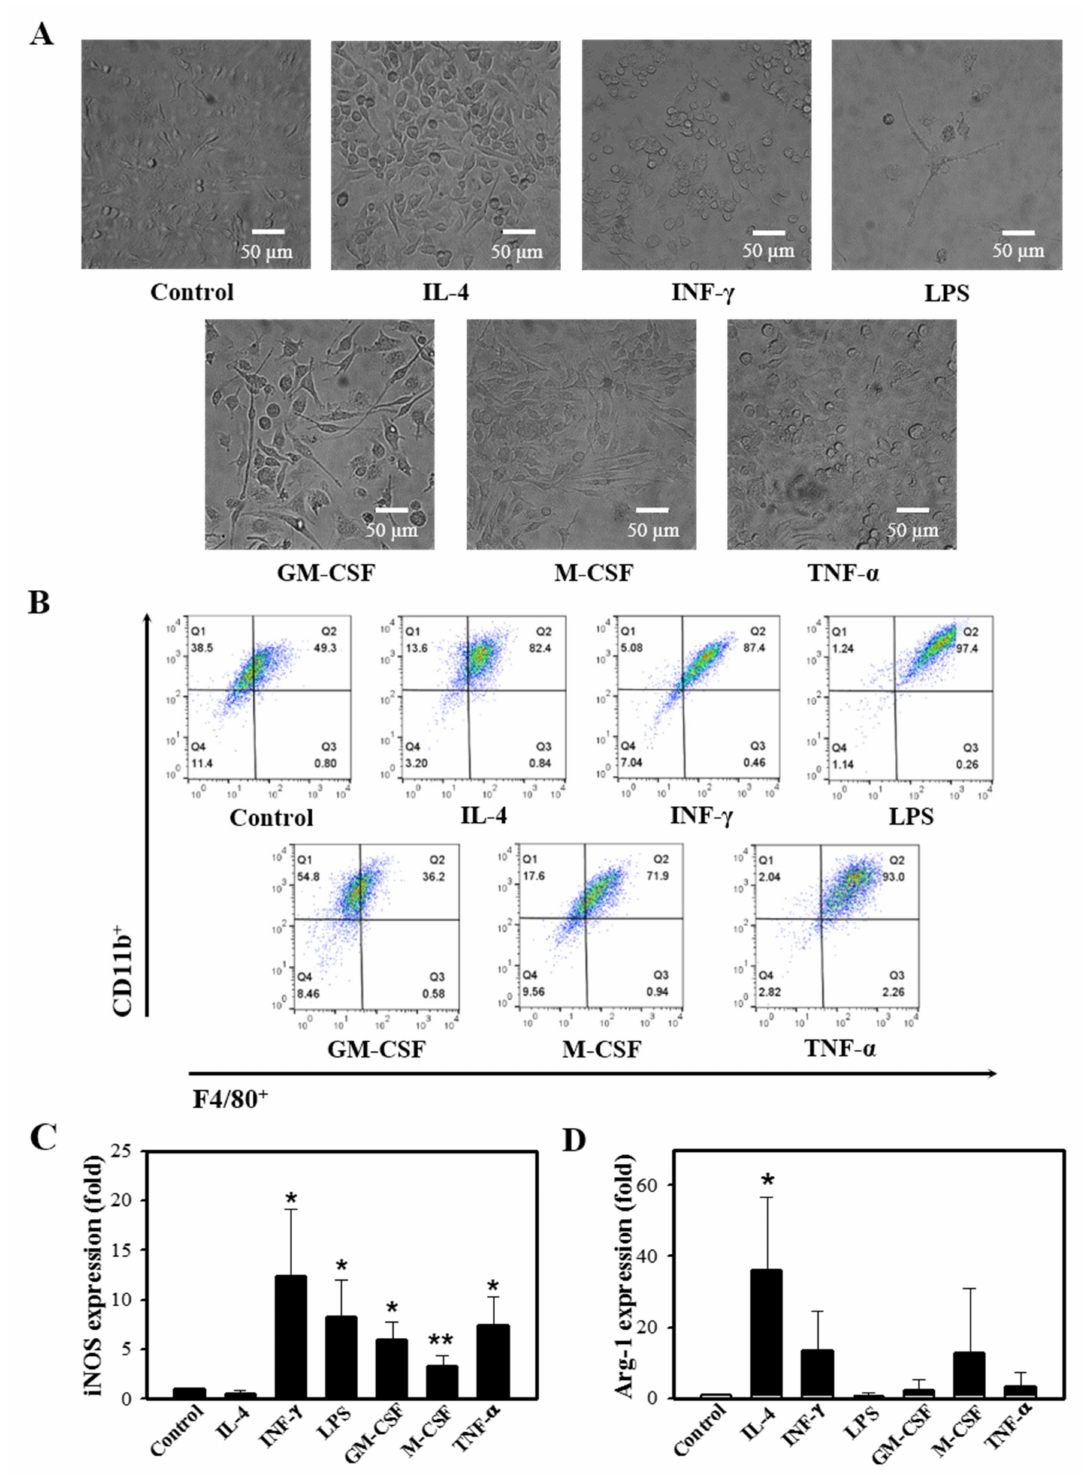
Figure 3. Different ligands induce M1/M2 polarization. Murine BMCs were treated with a variety of stimuli, such as 10 ng/mL IL-4, 50 ng/mL IFN- γ , 10 µ g/mL LPS, 10 ng/mL GM-CSF, 30 ng/mL M-CSF, and 10 ng/mL TNF- α in the presence of 30 ng/mL M-CSF on day 5, followed by 5 days of incubation. ( A ) Cell images after 10 days of differentiation were acquired (n = 4). ( B ) Representative flow cytometry of cells in response to stimuli, X axis: F4/80 + , Y axis: CD11b + (n = 3). ( C , D ) Relative gene expressions of iNOS and Arg-1 by the M1/M2 modulating stimuli were determined by qRT-PCR (n = 3). Results are presented as mean ± SD; * p < 0.05 and ** p < 0.01 compared to control (Student’s t